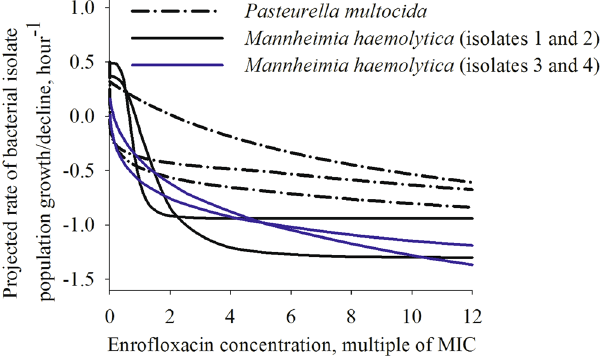
Figure 3. Projected rates of population growth/decline of three isolates of Pasteurella multocida and four isolates of Mannheimia haemolytica when exposed to different concentrations of the fluoroquinolone enrofloxacin. (The isolate number corresponds to that in Table 1).